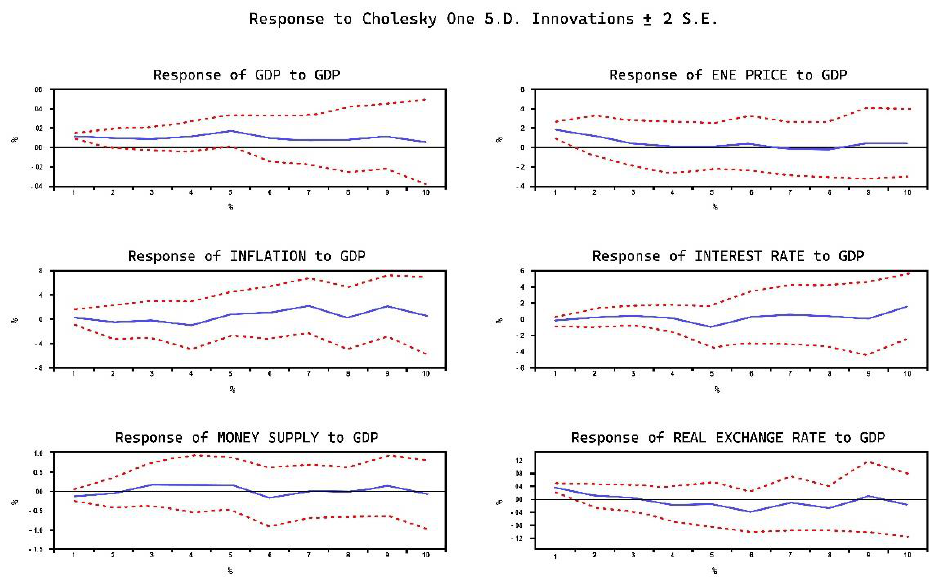
Figure 7. IRF to GDP (VAR IRF with intercept using annual data for 1980 –